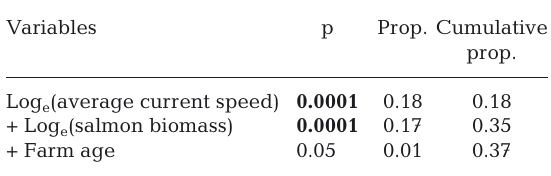
Fig. 3. Log-log relationship between predicted current speed (averaged over depth and over 1 tidal cycle) and aver- age sediment sulfide concentration in annual regulatory monitoring at salmon farms in SWNB, 2006 to 2009